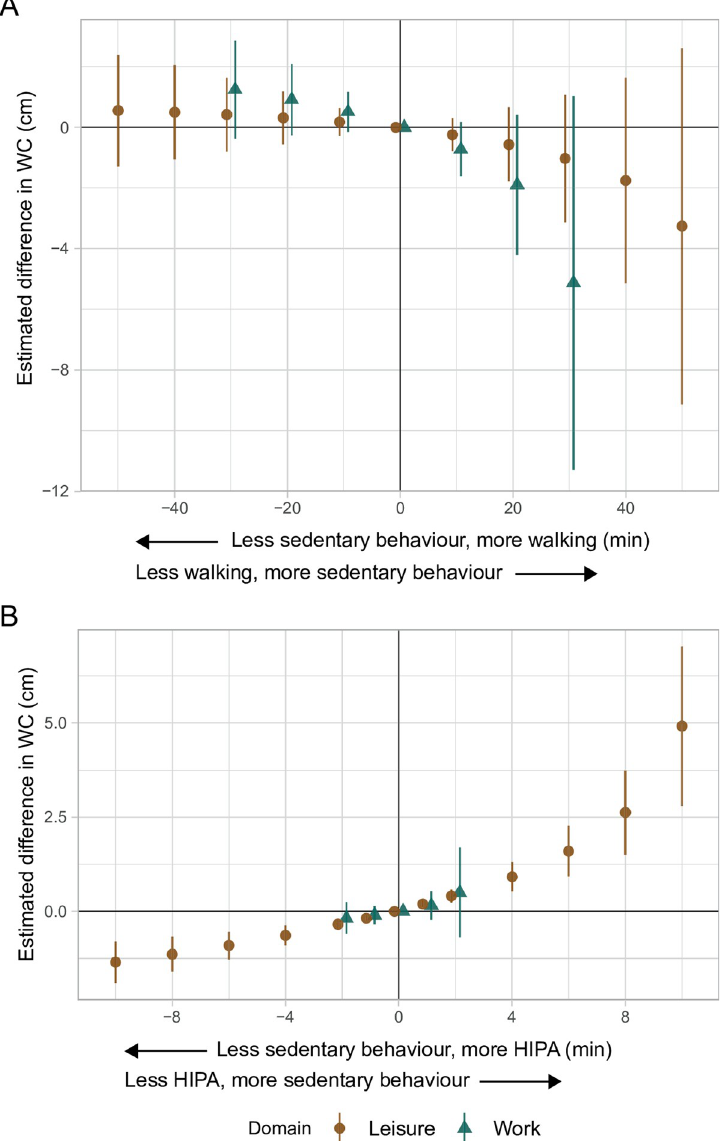
Fig 3. Adjusted estimated differences in waist circumference (cm, y-axis) given the reallocation of time between sedentary behaviour and A) walking, and B) HIPA among 652 adults. A negative value on the x-axis reflects the pairwise reallocation of time from sedentary behaviour to walking or HIPA, while a positive value reflects the reallocation of time from walking or HIPA to sedentary behaviour. The origin represents the reference composition (i.e., 372.7 and 234.2 min sedentary behaviour, 127.0 and 74.6 min standing, 49.1 and 22.5 min moving, 56.8 and 32.5 min walking, and 10.9 and 2.5 min HIPA, during leisure and work, respectively, and 457.3 min in bed). The difference in outcome was calculated by subtracting the estimated outcome of the reference composition from the estimated outcome for each reallocated composition. WC is waist circumference. HIPA is high-intensity physical activity (i.e., sum of climbing stairs, running, cycling, and rowing). Vertical lines correspond to the 95% confidence